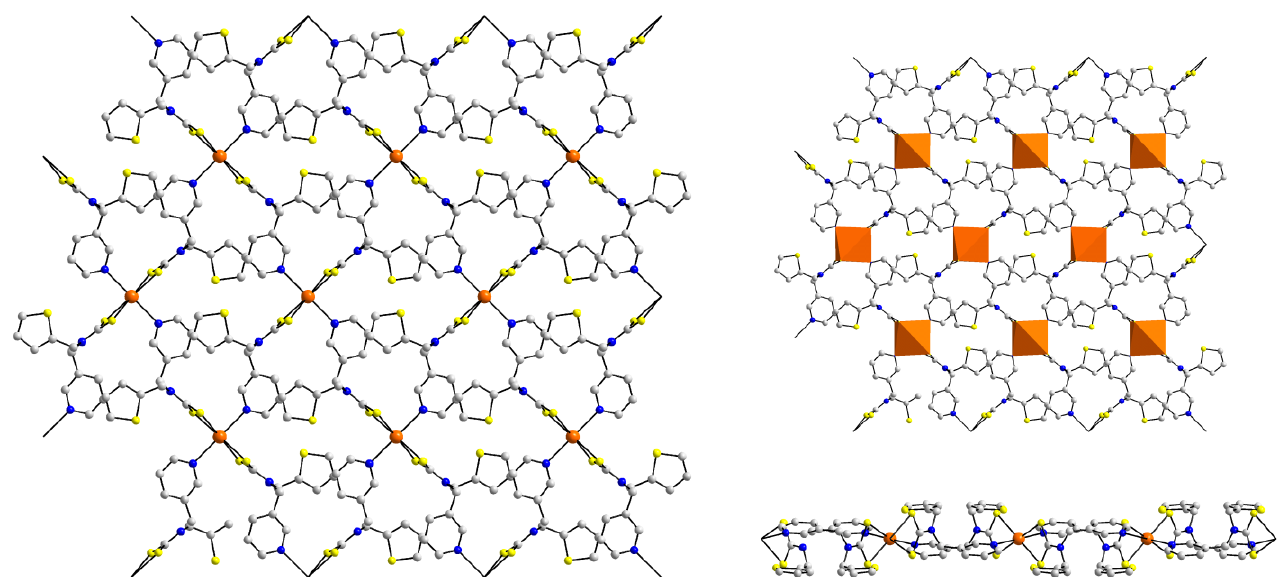
Figure 10. Plan and side-on views of the two-dimensional array in the crystals of [Cd(L 16 ) 2 ] n ( 33 ); one plan view highlights the hexagonal pattern of the coordination polyhedra.